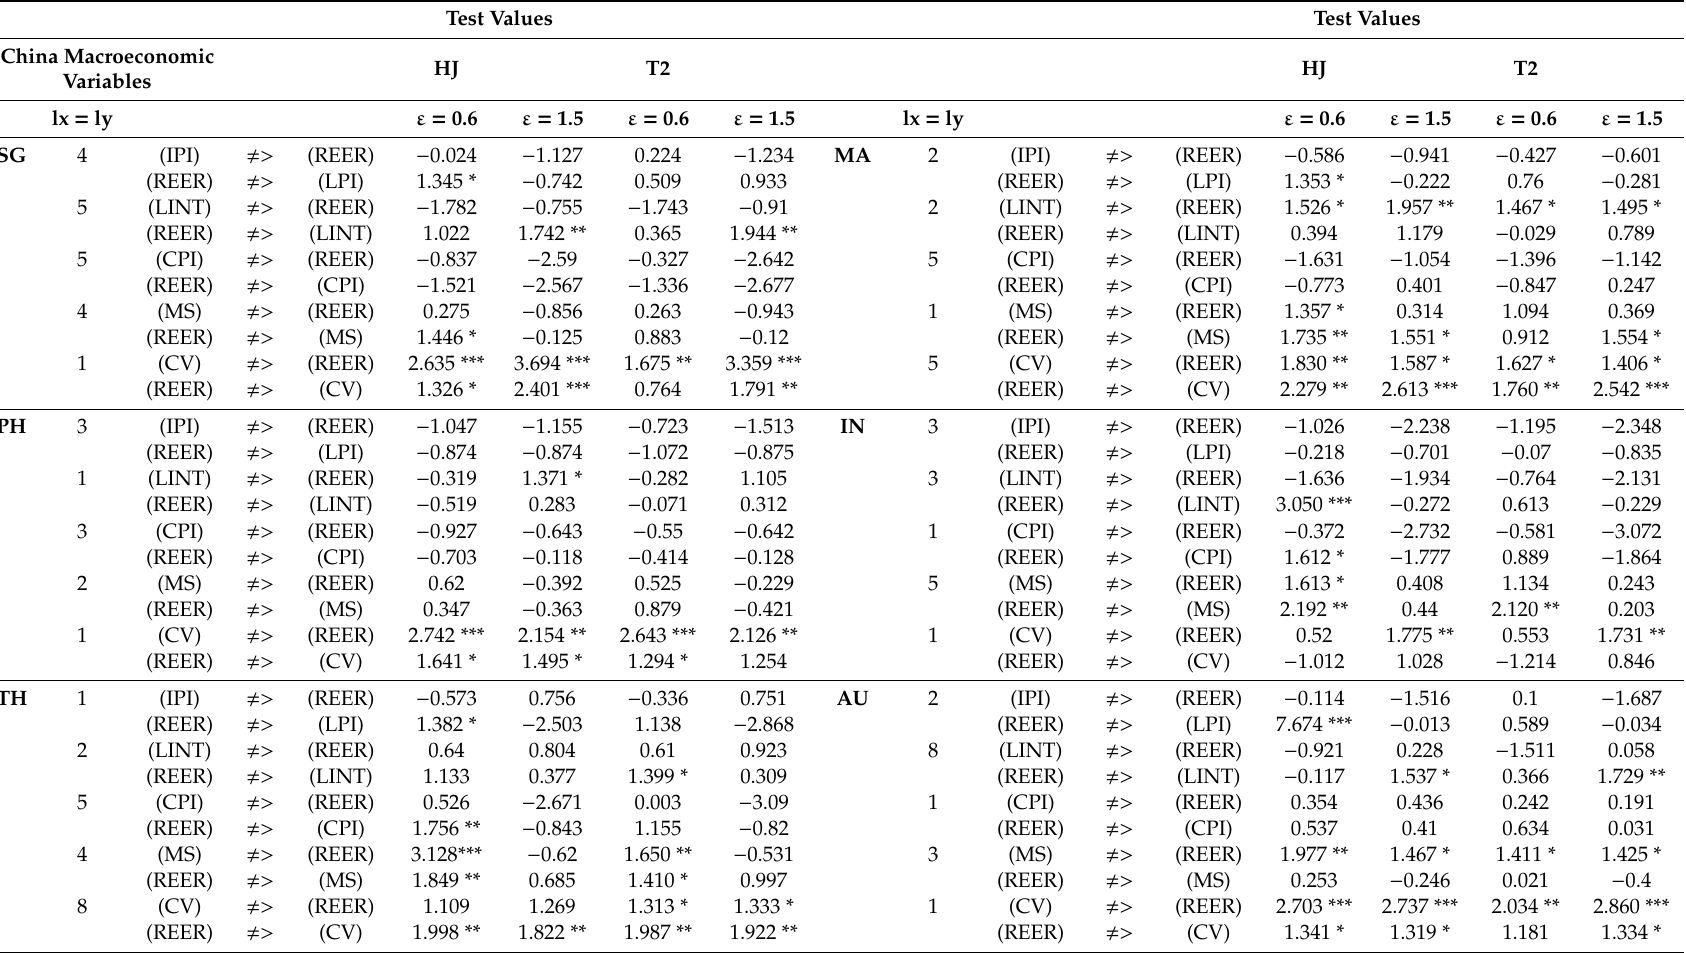
Table 11. Non-linear causality test between REERs and the China macroeconomic variables: January 1998–April 2017. Test